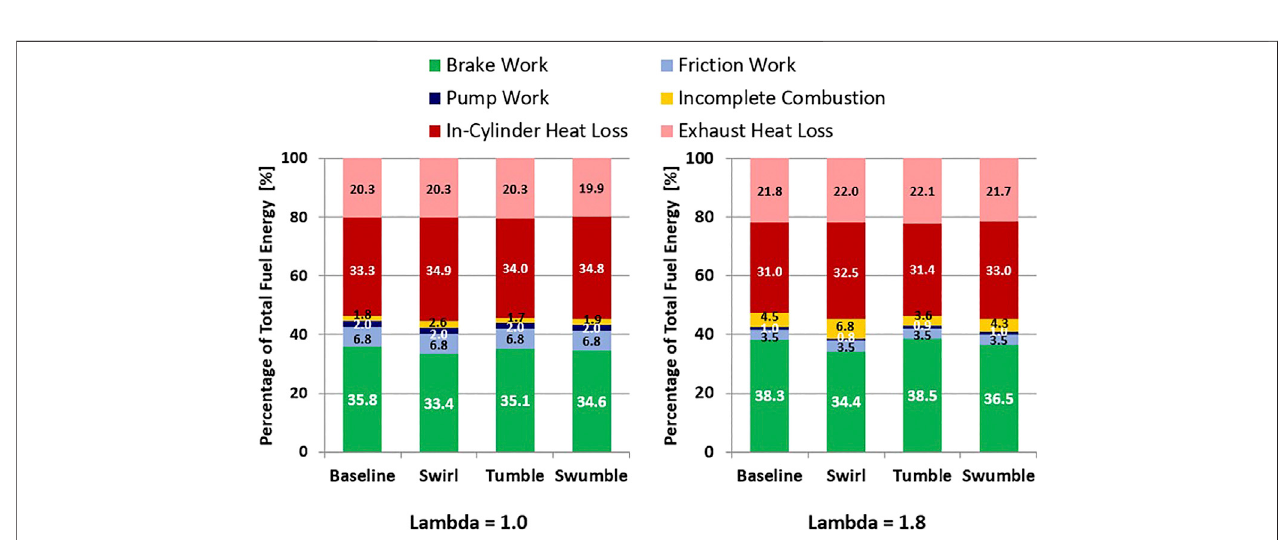
FIGURE 8 | Ef fi ciency loss analysis as a percentage of total fuel energy; 1,500 rpm, 6 bar BMEP, lambda (cid:1) 1.0 (left) and lambda (cid:1) 1.8 (right) .